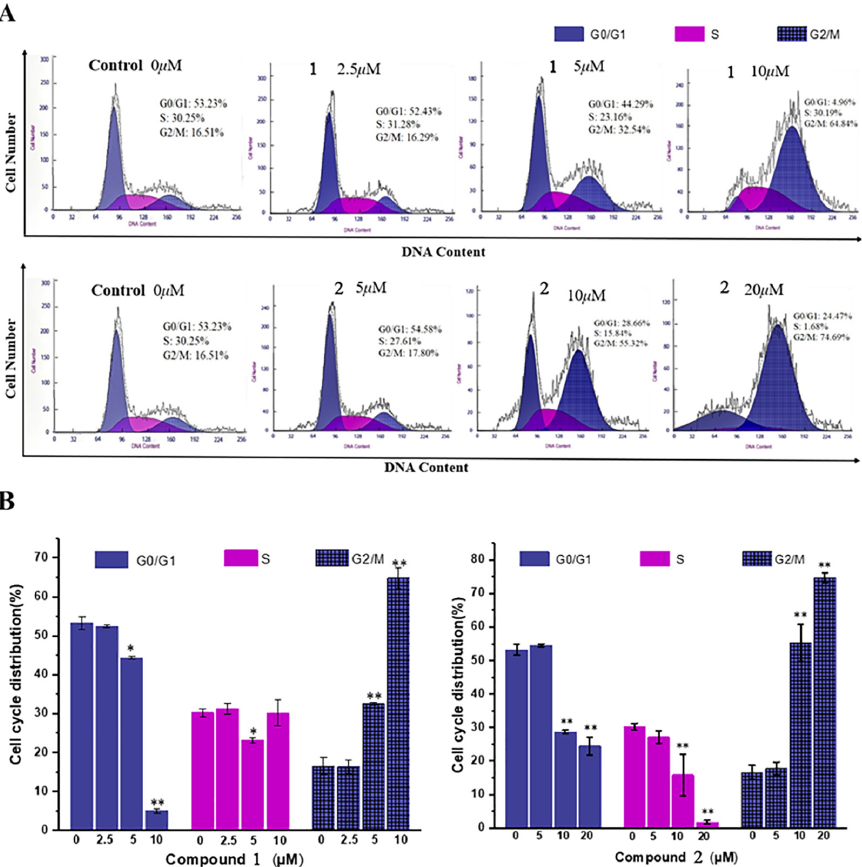
Figure 4. Effect of compounds 1 and 2 on the cycle of HepG2 cells. ( A ) HepG2 cells were treated with compounds 1 (0, 2.5, 5, and 10 μ M) and 2 (0, 5, 10, and 20 μ M) for 24 h, and then the cells were fixed, stained with PI, and analyzed by flow cytometry. ( B ) The quantification of cell cycle distribution. Data are the means ± SD of three independent experiments. * p < 0.05, ** p < 0.01, vs. control group.